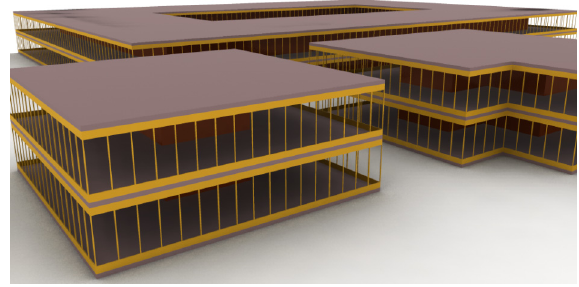
Figure 14: Office rectangular, L-shape and atrium buildings.